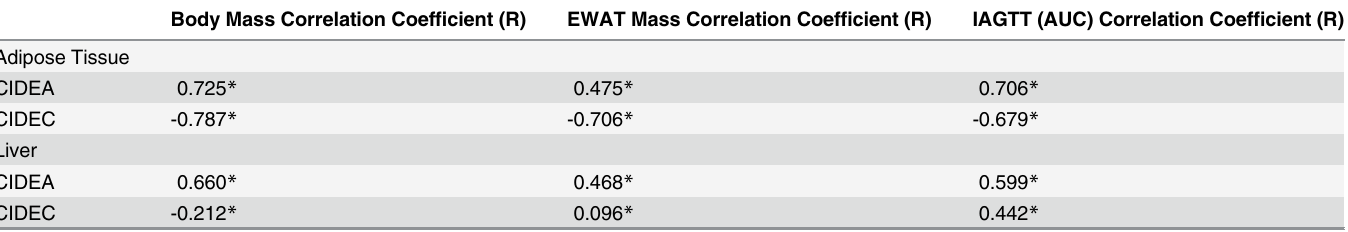
Table 2. CIDE protein expression in adipose tissue and liver from CON-SED, CON-WR, HFD-SED, and HFD-WR mice is related to measures of adi- posity and insulin